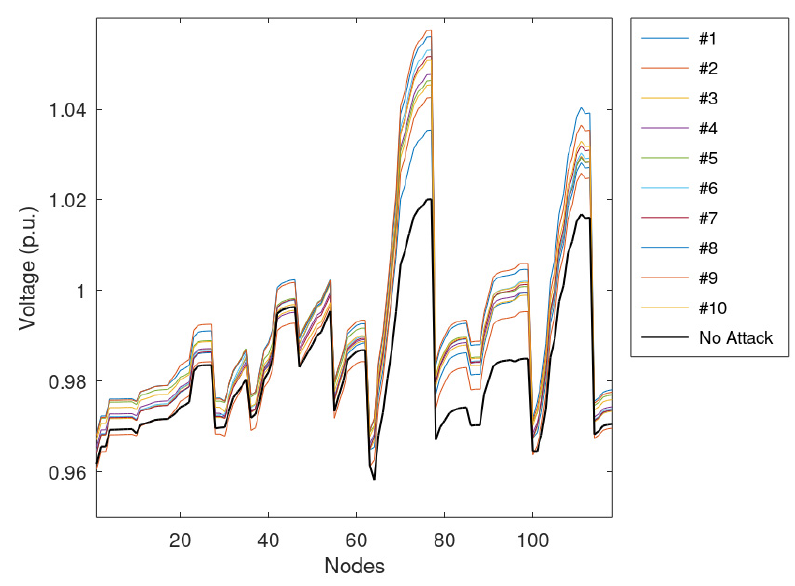
Figure 8. Average voltage of the nodes assuming that 25% of measurements are manipulated.